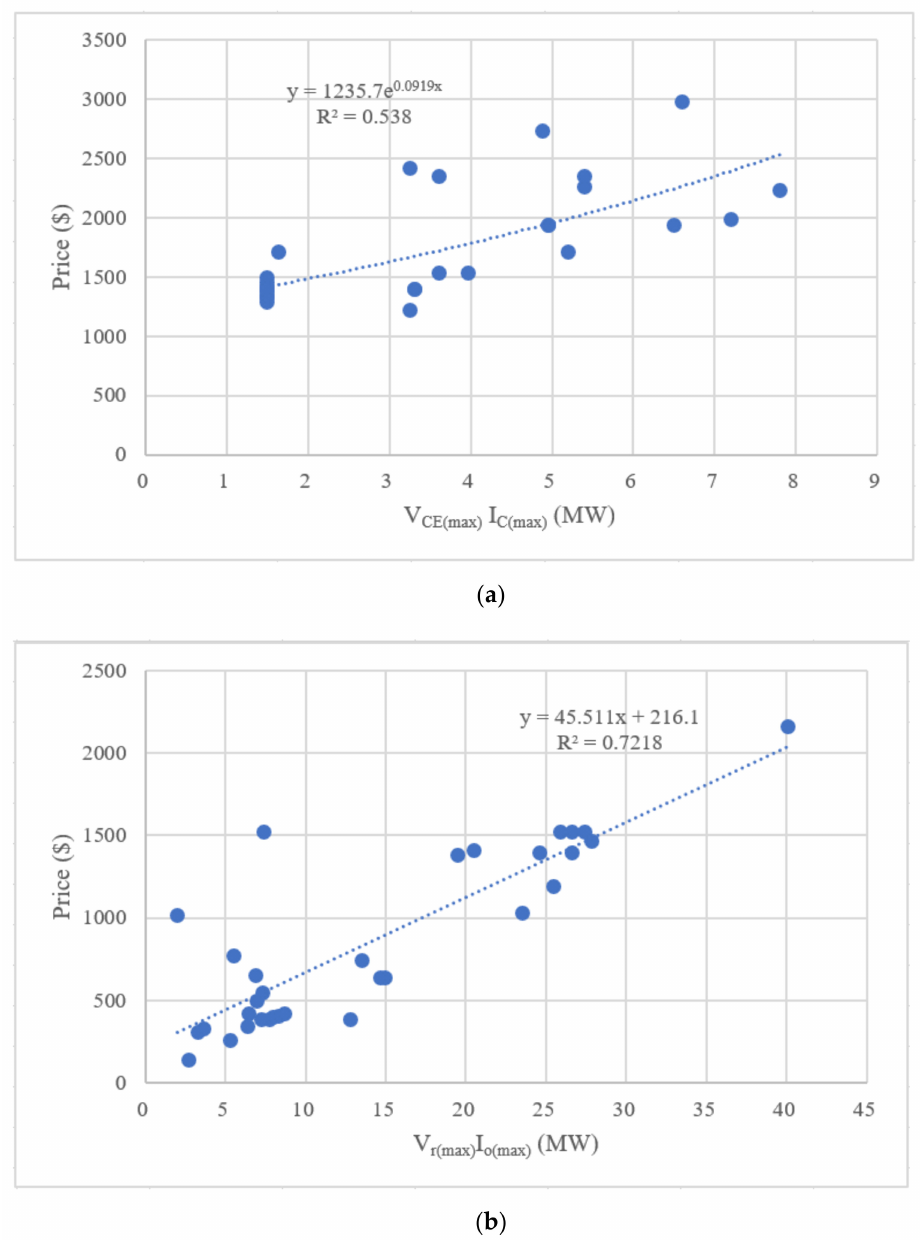
Figure 13. Cost model of switching devices: ( a ) IGBT; ( b )